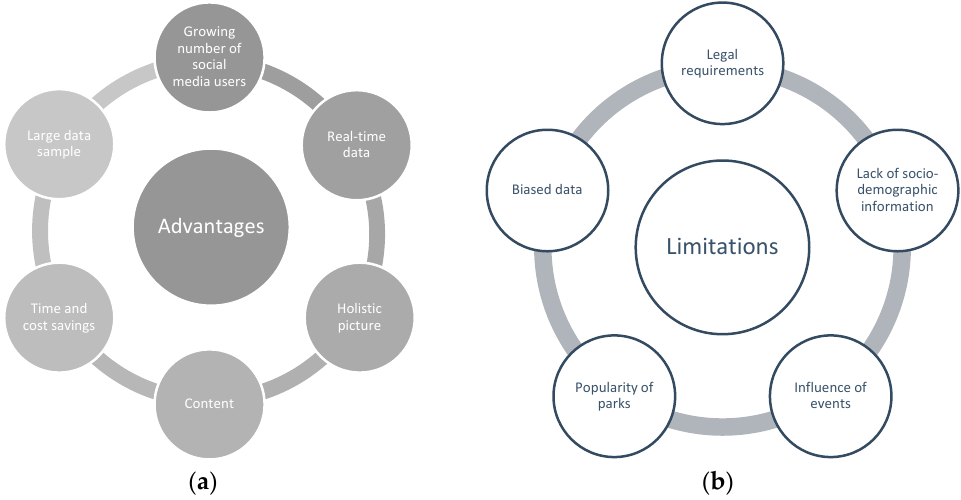
Figure 4. ( a ) Advantages of using social media data for understanding urban park use; ( b ) limitations of using social media data for urban park use.